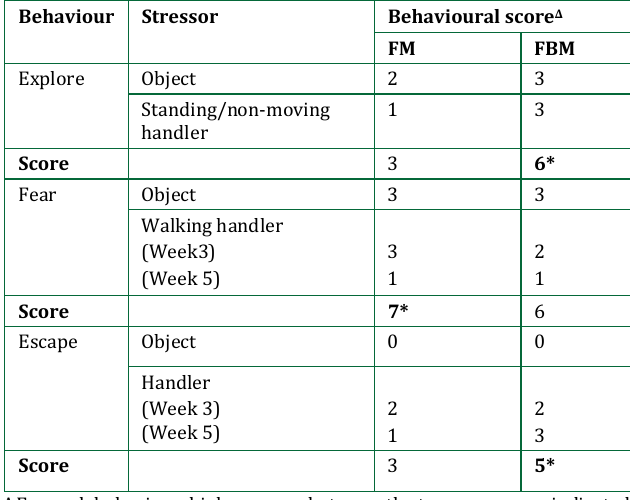
Table 3: Rating scores for induced behaviour (Score: 0, no such behaviour; 1, least likely towards the behaviour; 2, likely towards the behaviour; 3, very likely towards the